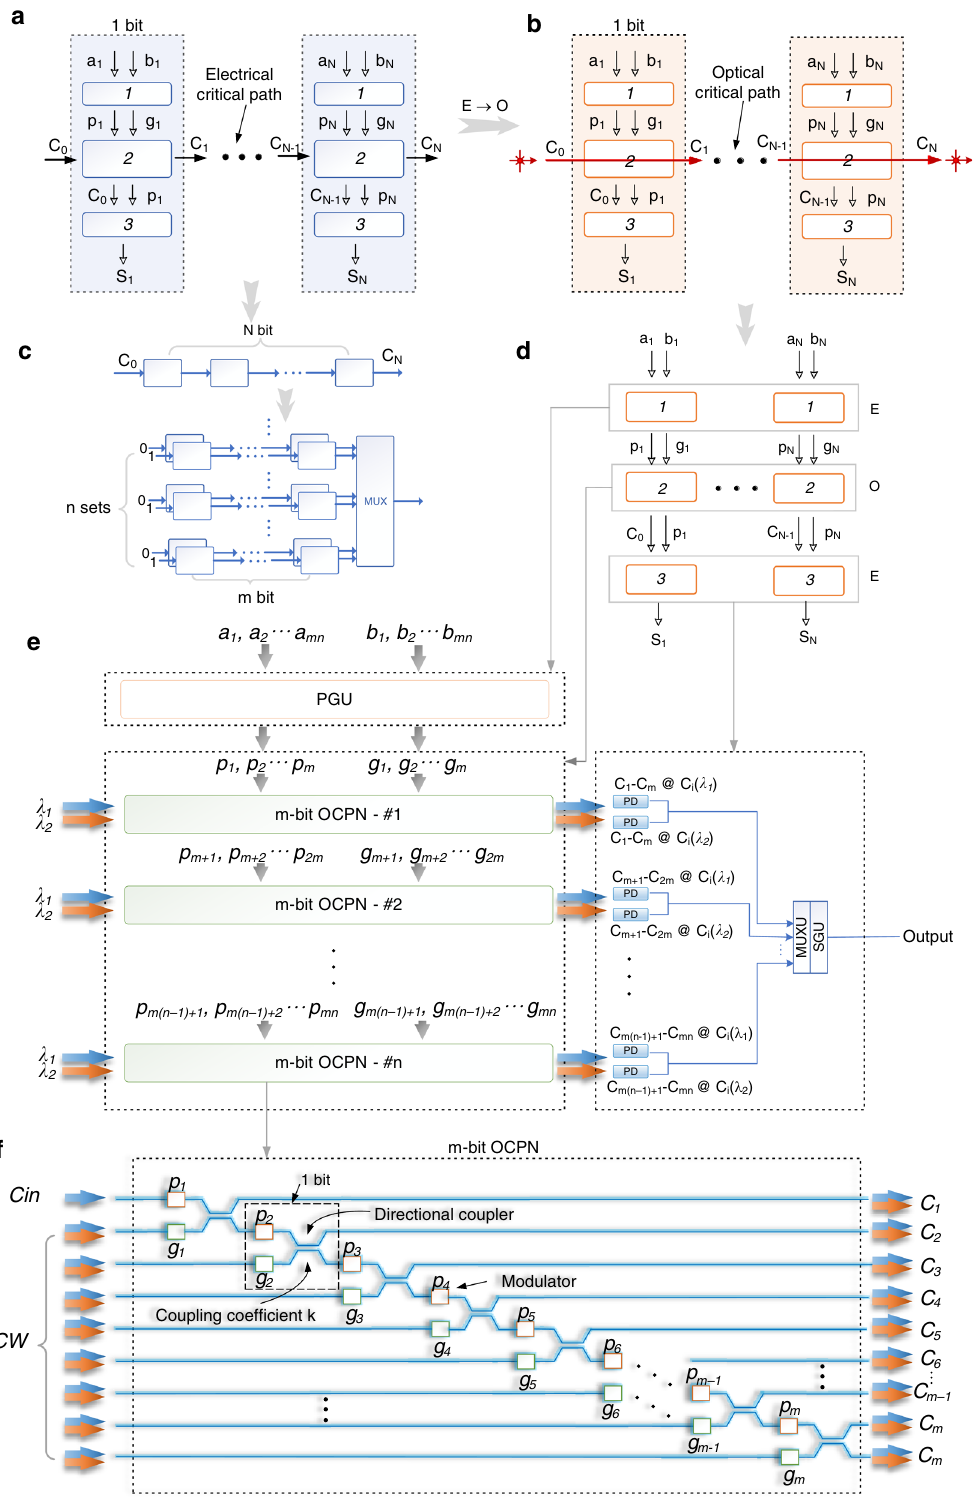
Fig. 1 General architecture of the EPALU. a Schematic of a conventional transistor-based ripple-carry full adder, with carry signals rippling along the critical path. b General schematic of the electronic-photonic full adder. The components along the critical path are replaced by optical ones and light transports the carry signals from one bit to another. c Schematic of a ripple carry adder (upper) and a carry select adder (lower). d Variant of ( b ), to show the correspondence between ( b ) and ( e ). e General architecture of the WDM-based EPALU, consisting of a (p, g) generation unit (PGU), n sets of m -bit optical carry propagation networks (OCPNs) and an array of fast photodetectors (PDs) along with a network of electronic multiplexer units (MUXU) and an electronic sum generation unit (SGU). f Schematic of the m -bit OCPN consisting of an optical network with modulators and passive couplers. Different input combinations will lead to different